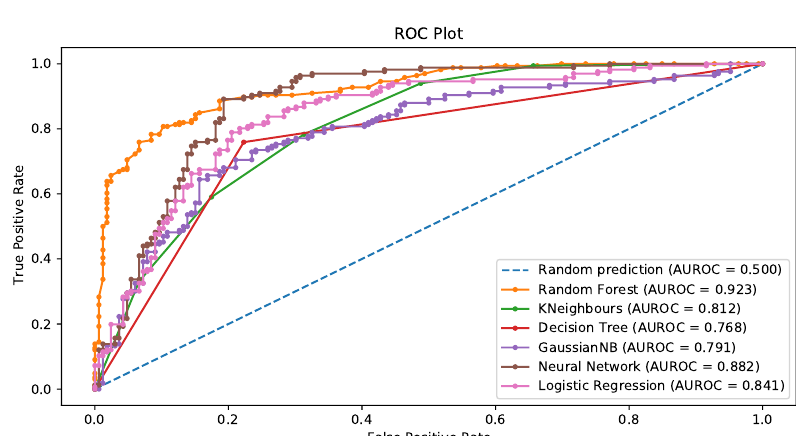
Figure 12. SMOTE.